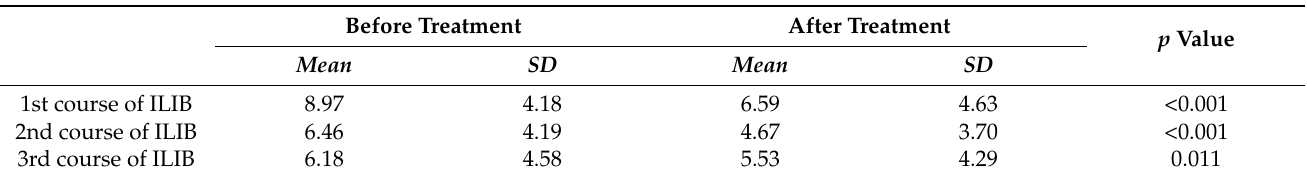
Table 5. The Pittsburgh Sleep Quality Index (PSQI) of patients with musculoskeletal disease before and after receiving ILIB